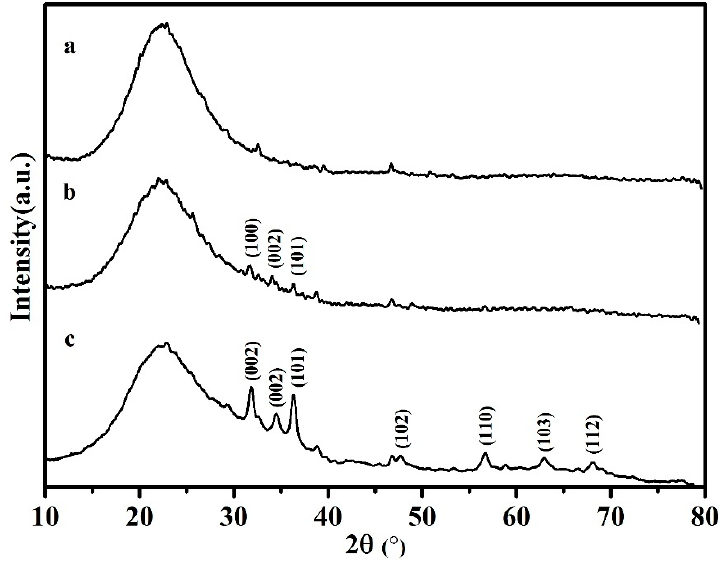
Figure 3. XRD of ( a ) amorphous SiO 2 ; ( b ) ZnO–SiO 2 -pH5.0; and ( c ) ZnO–SiO 2 -pH7.0.